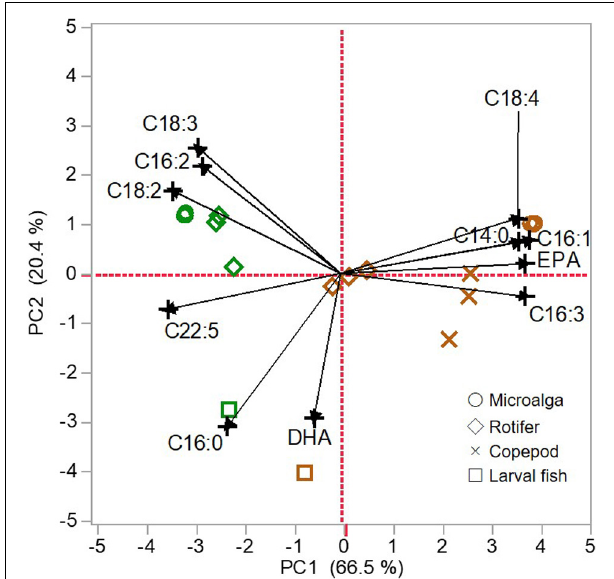
FIGURE 6 | Principal component analysis (PCA) of total lipid fatty acid compositions of microalgae (circle), zooplankton (rotifers, diamond; copepods, cross), and larval fish (square). Green: docosahexaenoic acid-supplemented Super Fresh Chlorella (SFC). Brown: algal mixture. The PCA was calculated using proportions of C14:0, C16:0, C16:1, C16:2, C16:3, C18:2, C18:3, C18:4, EPA, C22:5, and DHA, which were significant differences of one or more percent between SFC and algal mixture. The PC1 scores were correlated with C14:0 ( r = 0.913), C16:1 ( r = 0.973), C16:2 ( r = 0.708), C16:3 ( r = 0.944), C18:2 ( r = 0.860), C18:3 ( r = 0.733), C18:4 ( r = 0.909), EPA ( r = 0.892), C22:5 ( r = 0.892); and the PC2 ones were correlated with C16:0 ( r = 0.783) and DHA ( r = 0.742).